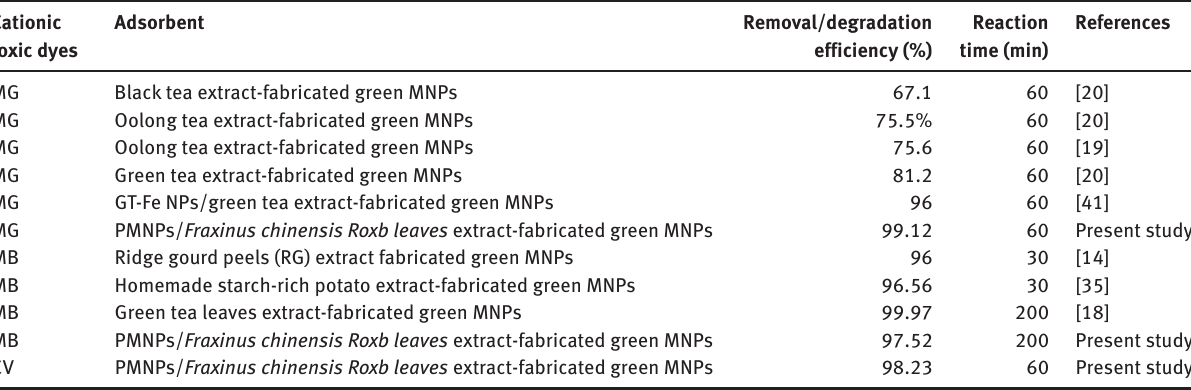
Table 3: Comparison of the phytogenic magnetic nanoparticles (PMNPs) removal/degradation performance with the other reported green magnetic adsorbents employed for the degradation of the cationic toxic dyes from the aqueous solution.